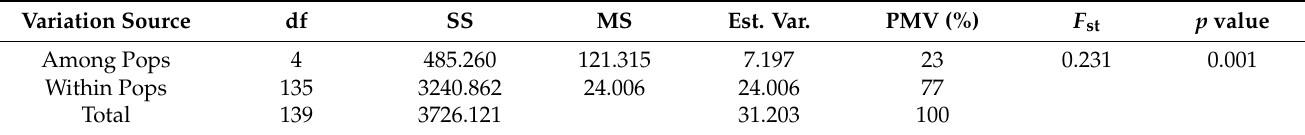
Figure 2. Genetic distance and genetic identity among groups. ( A ): Nei’s genetic distance; ( B ): Nei’s genetic identity. Table 5. An analysis of molecular variance among and within Camellia species.